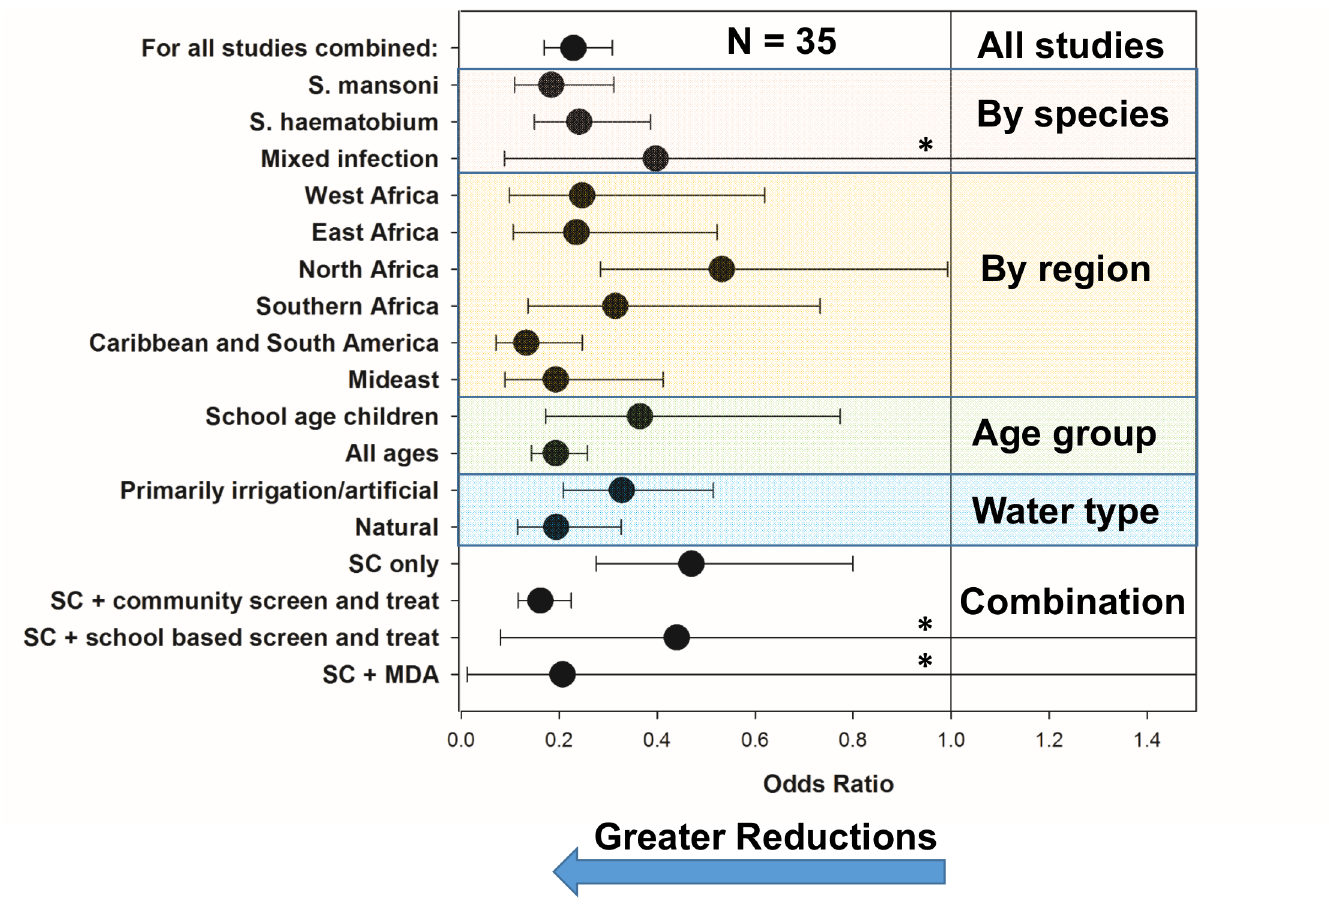
Fig 4. Odds ratios for Schistosoma infection, as measured by human prevalence, after implementation of mollusciciding programs. Black circles indicate odds ratios estimated by random effects meta-analysis for Schistosoma infection prevalence after mollusciciding, as compared to pretreatment levels. Whisker bars indicate the 95% confidence interval for the OR estimates. Asterisks ( * ) indicate that the graphing of the upper confidence limit was truncated for that category (numeric details are provided in Supporting Information file S1 Table). Results are shown for all studies reporting human prevalence data before and after control (top line, N = 35), and for study subgroup categories classified according to parasite species, geographic region, which age groups were included, the types of water bodies treated, and whether the program included snail control (SC) only, or mollusciciding combined with some form of drug treatment